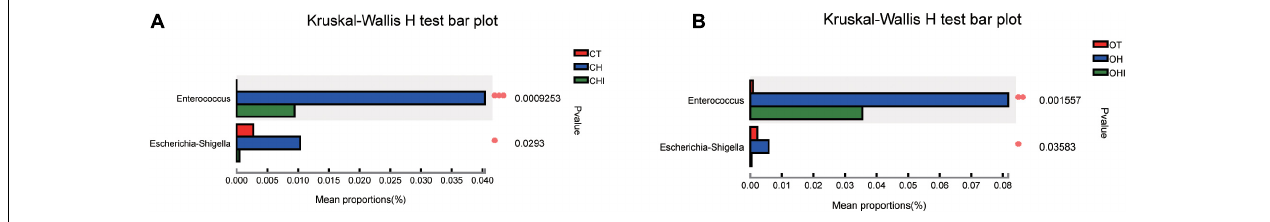
FIGURE 6 | Conditioned pathogenic bacteria. Relative abundance of cecal microbiota at the genus level. (A) Conditioned pathogenic bacteria showed differential abundance at the genus level among the CT, CH, and CHI groups according to one-way ANOVA. (B) Conditioned pathogenic bacteria showed differential abundance at the genus level among the OT, OH, and OHI groups according to one-way ANOVA. * indicates a significant difference compared with OT ( p < 0.05), ** indicates a significant difference compared with OT ( p <